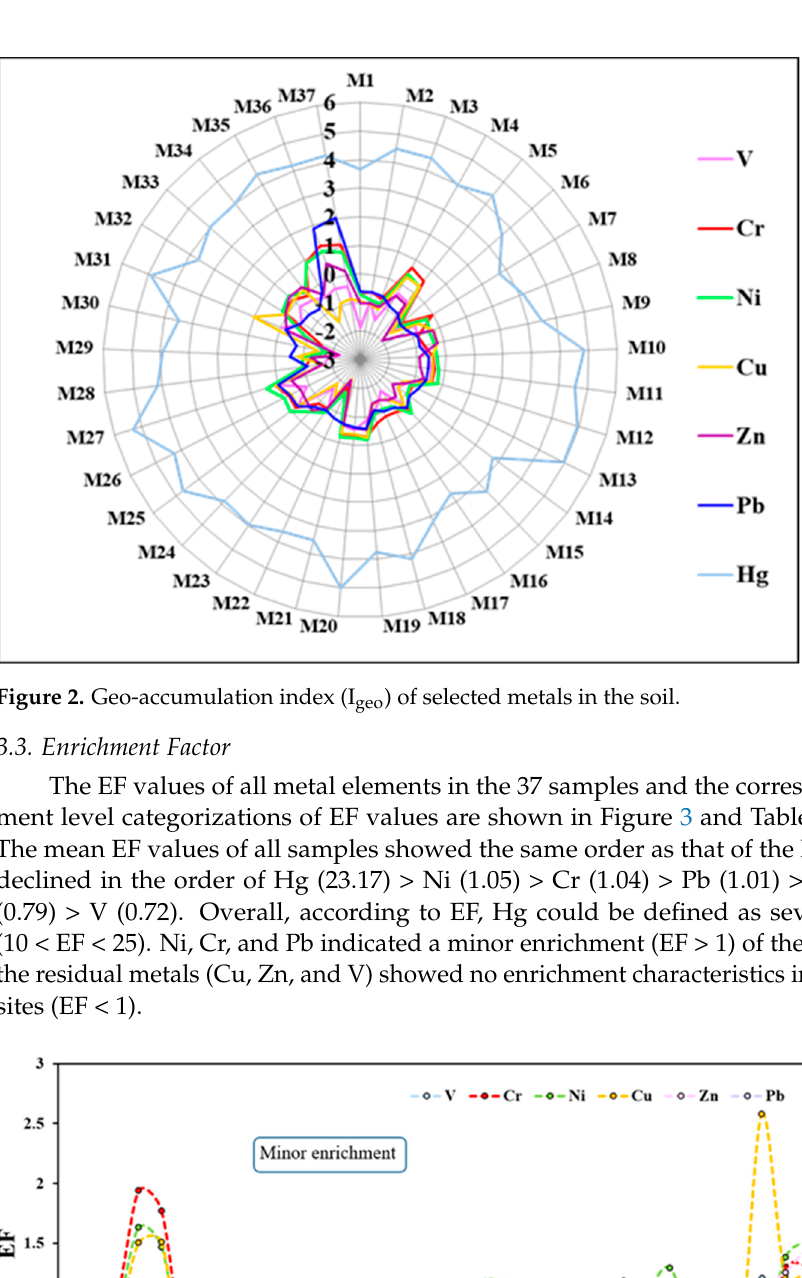
Figure 3. The EF values of each sampling of soil in Linyi City.